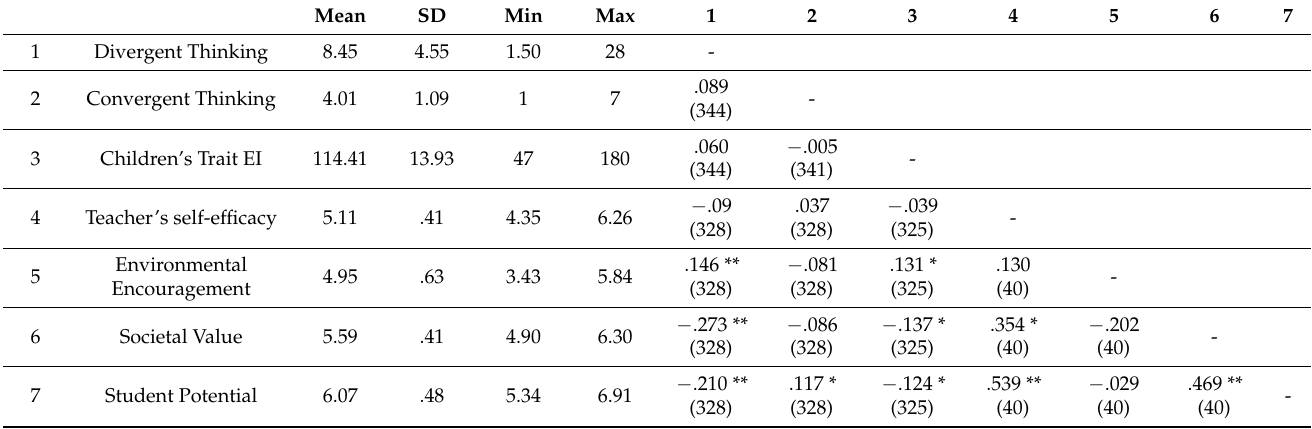
Table 1. Descriptive statistics and correlations (Pearson R and number of participants, in brackets, are shown) between the average performance in the EPoC divergent and convergent tasks, children’s trait EI, and teacher’s